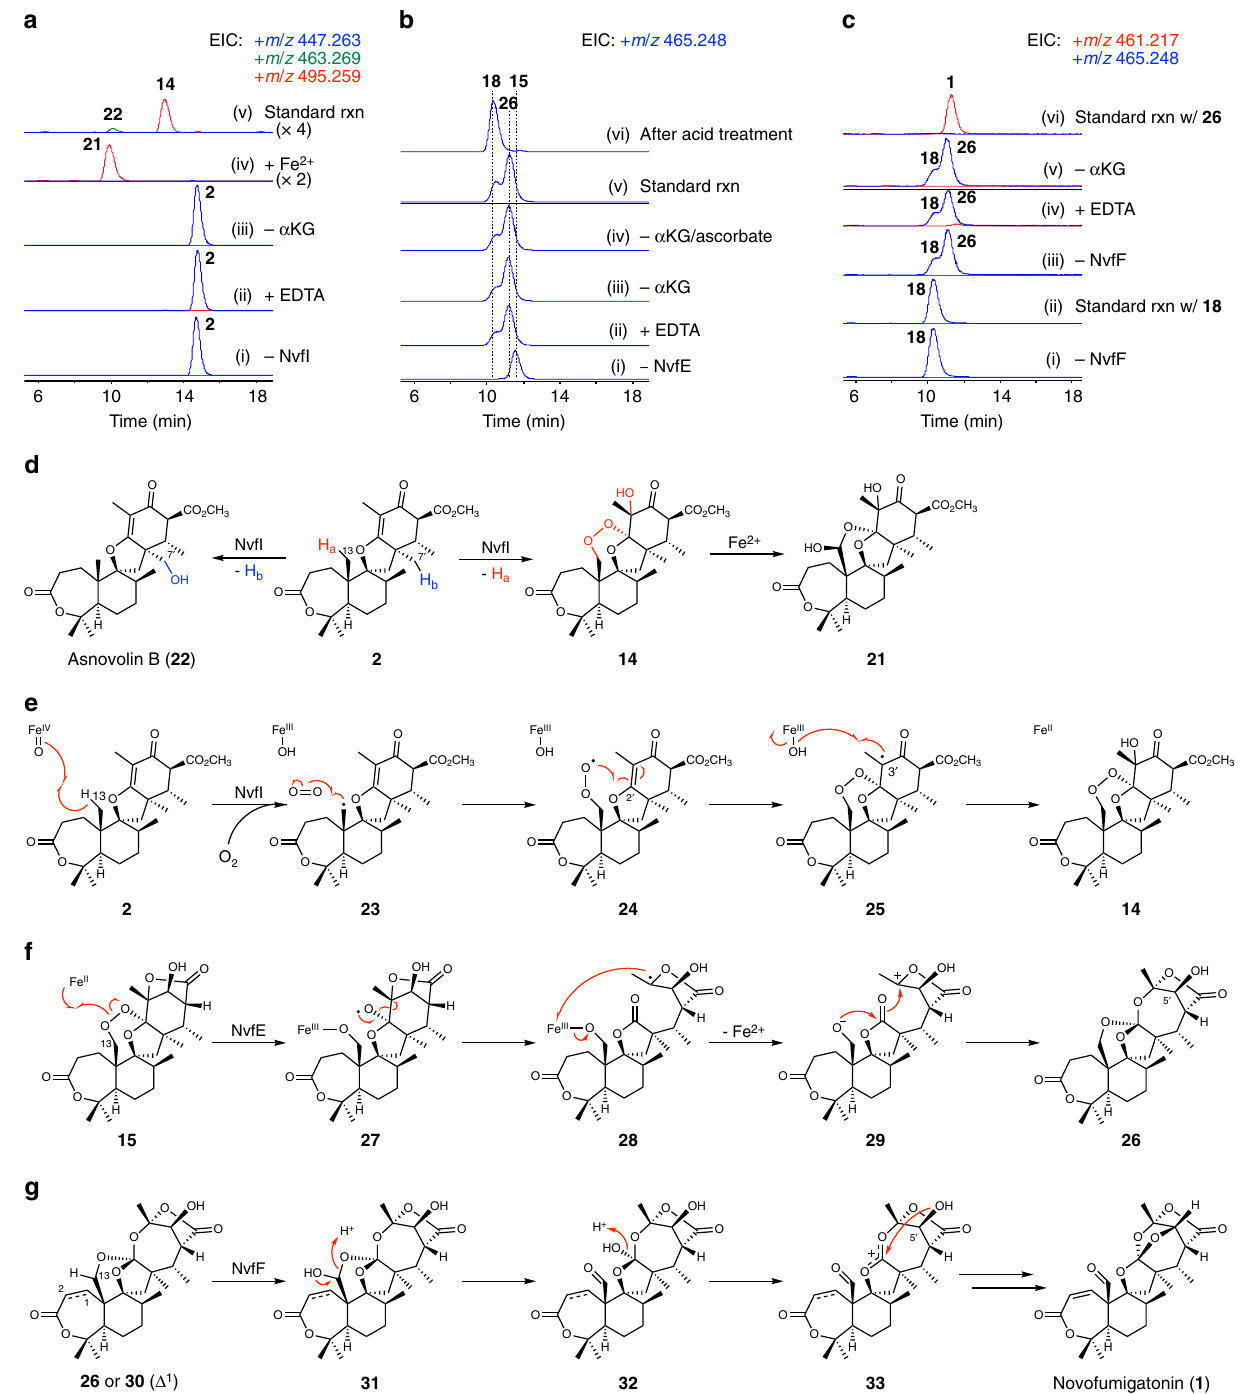
Fig. 4 Characterization of the key enzymes for novofumigatonin orthoesteri fi cation. a – c LC – MS analyses of the products from enzymatic reactions of a NvfI and 2 , b NvfE and 15 , and c NvfF and 18 (lanes i and ii) or 26 (lanes iii to vi). d Reactions catalyzed by NvfI and the Fe(II)-catalyzed rearrangement of 14 . NvfI produces 14 as the major product and 22 as a minor product. e Proposed reaction mechanism for the endoperoxidation by NvfI. f Proposed mechanism for the orthoesteri fi cation by NvfE. g Proposed mechanism for the aldehyde formation and transorthoesteri fi cation of the predicted NvfF